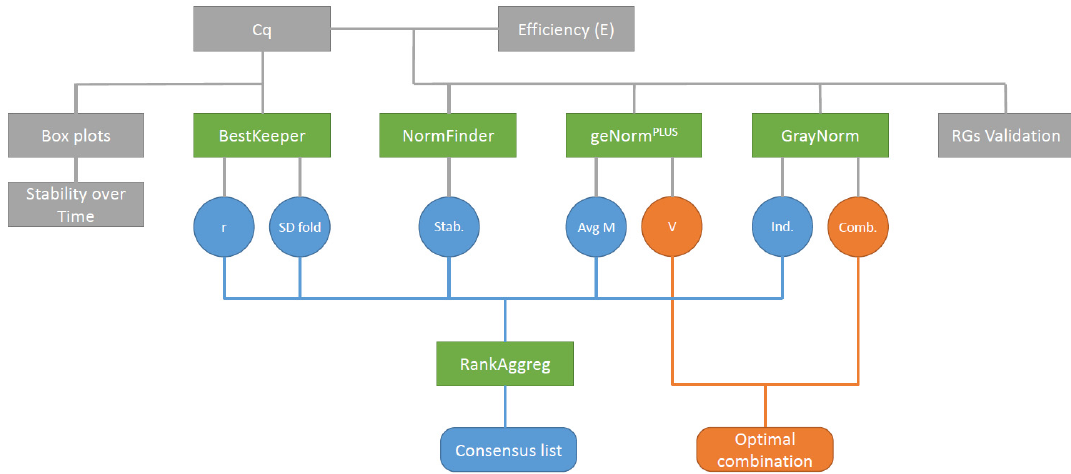
Figure 1. Data analysis workflow. Cycles of quantification (C q ) and PCR efficiency (E) were determined by qPCR and then used as input for the different gene ranking algorithms. Contrary to the other ranking algorithms, BestKeeper only used C q as input data. The ranking list produced by the different algorithms were then used as input data with RankAggreg to produce a consensus list. Grey boxes: raw data and descriptive statistics, green boxes: algorithms, circles: ranking algorithms output, round ‐ cornered rectangles: final outputs, blue circles: Data used to rank gene stability, orange circles: Data used to determine the optimal gene combination. Stab.: NormFinder stability value, Avg M: Average expression stability M, Ind.: GrayNorm ranking taking only single gene combinations into account, Comb.: GrayNorm ranking taking all gene combinations into account.